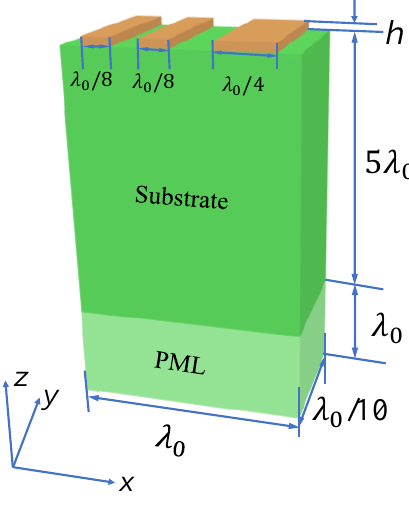
Figure 2. FEM model of a unit cell.